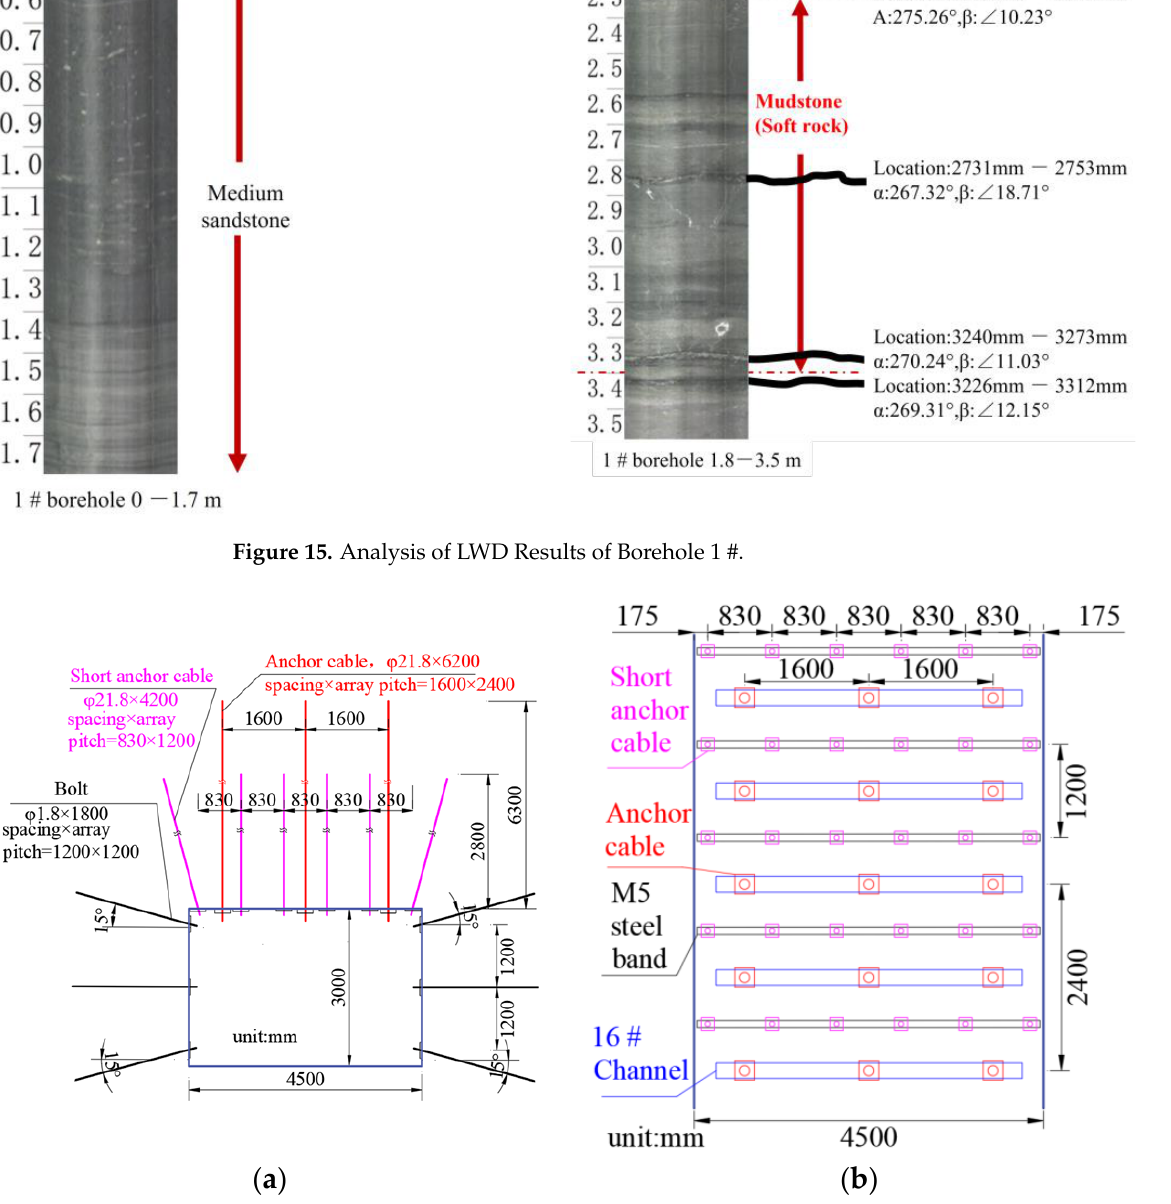
5 Figure 17. Site Effect. 7. Conclusions Theoretical analysis, numerical simulation, and field test methods were used to study the failure mechanism of layered roadway roofs in weak interlayers. The damage of weak intercalation and horizontal stress to layered roofs was analyzed. The research results are as follows: (1)